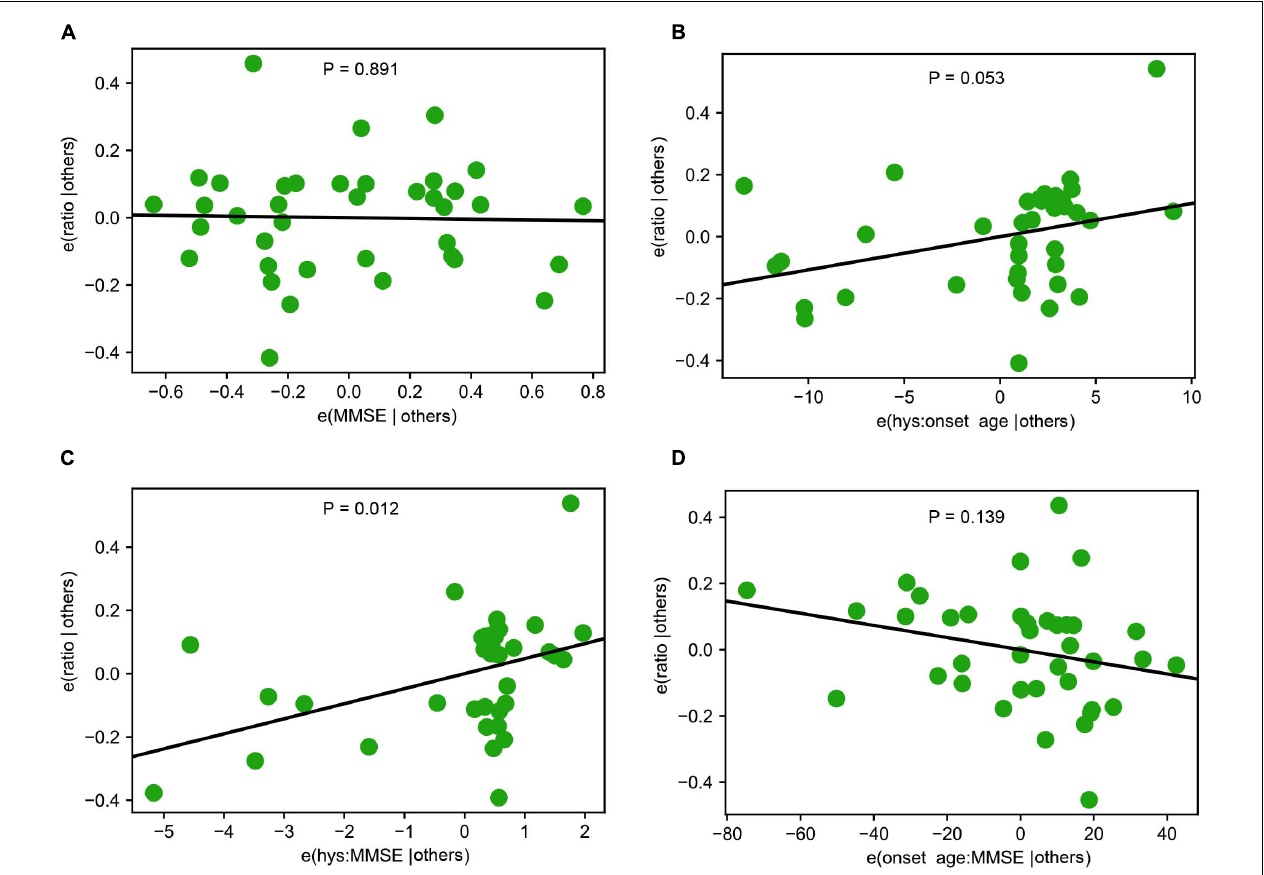
FIGURE 4 | Interactions among Demographic and Clinical Variables. (A) A representative partial regression plot shows the influence of a single variable, Mini-Mental Status Examination (MMSE), on Miro1 ratio. (B–D) Representative partial regression plots show the interactions of two variables for influencing Miro1 ratio. (B) Hoehn and Yahr Scale (hys) and onset age. (C) MMSE and hys. (D) Onset age and